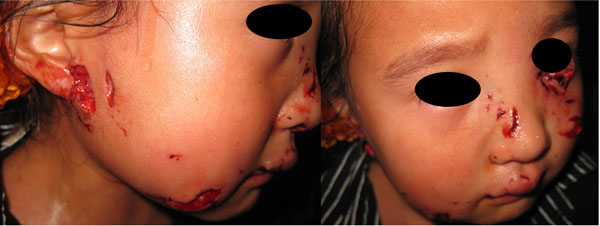
Little girl bitten by a dog. Her left nasolacrimal canal and eyelids were torn, and her right parotid gland and nose were also injured.